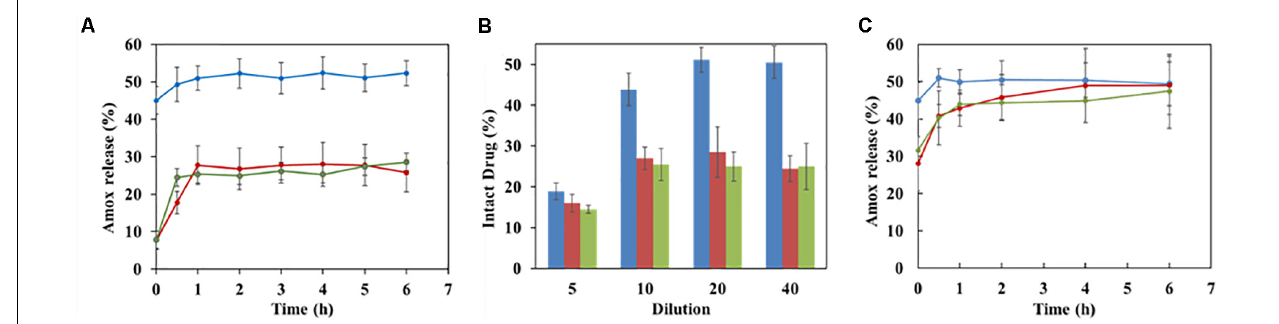
FIGURE 6 | Effect of coating on Amox release in water (A,B) and in PBS (C) . (A) Release kinetics of Amox in water from nanoMOFs (1 mg/mL) before or after coating, with a dilution factor of 20; (B) Effect of dilution factor on Amox release after 4 h incubation at 37 ◦ C in water (Blue: uncoated nanoMOFs; red: DOPC coated nanoMOFs; Green: DOPC and PEG-lipid conjugate coated nanoMOFs).